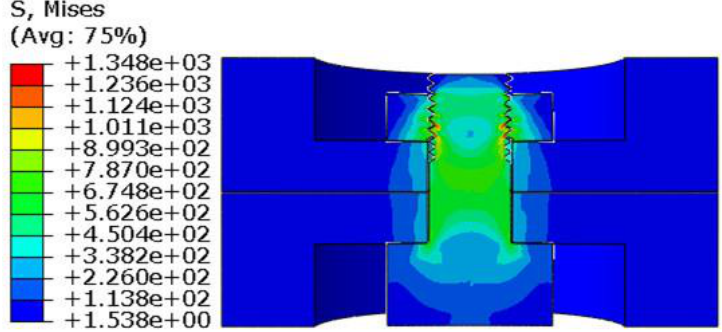
Metals 2018 , 8 , x FOR PEER REVIEW Figure 9. Stress contours of the threaded connections after being pre-tightened.